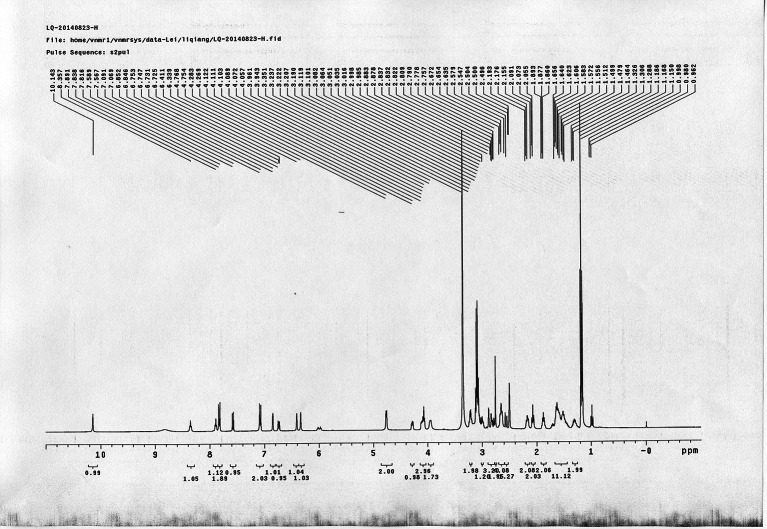
1H NMR spectra of bAL 2.